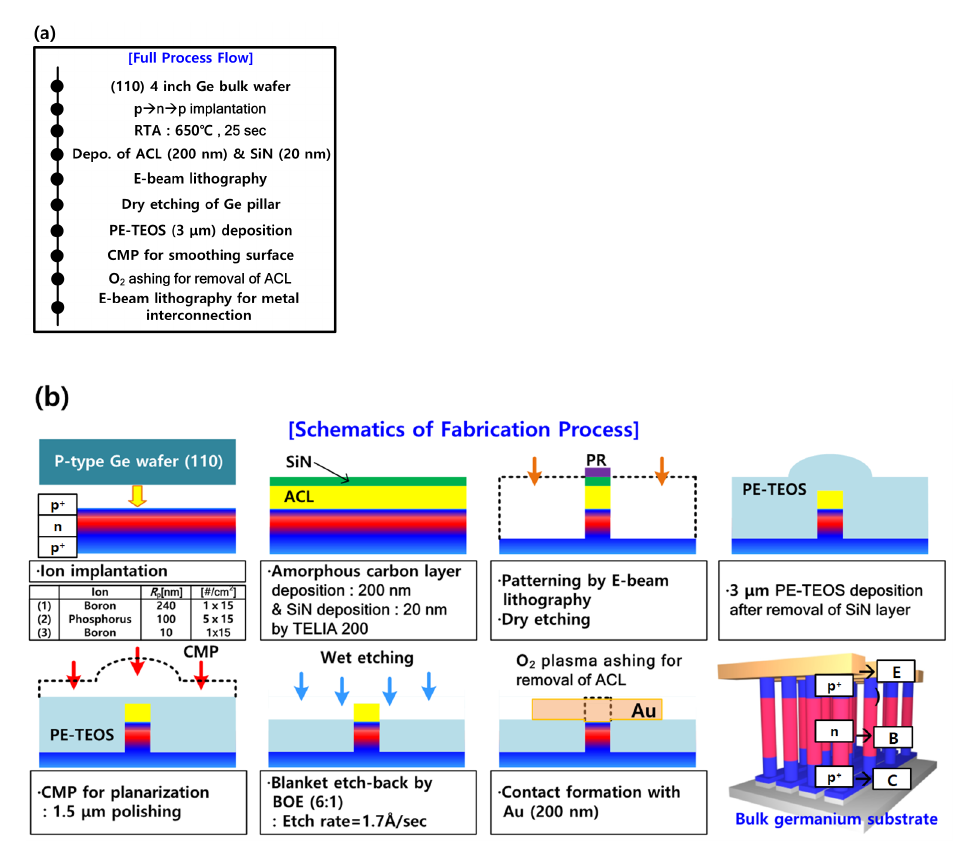
Figure 1. ( a ) Process flow of the fabricated vertical Ge biristor with the p + -n-p + structure by use of CMOS process technology. ( b ) Schematics of fabrication process for the vertical-type Ge biristor with open-base (floating) structure.